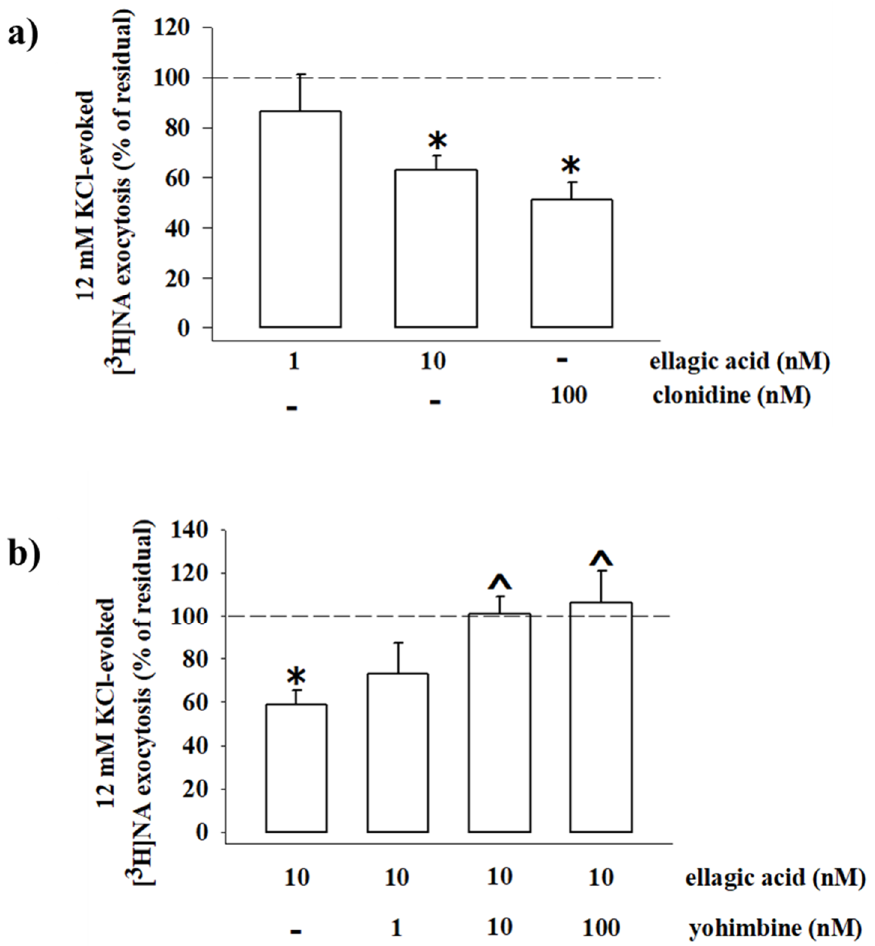
Figure 10. Ellagic acid mimics clonidine in inhibiting the 3 [H]noradrenaline ( 3 [H]NA) exocytosis from mouse hippocampal synaptosomes, and its effect is reversed by yohimbine. ( a ) Effects of ellagic acid (1 and 10 nM) and clonidine (100 nM) on the 12 mM KCl-evoked 3 [H]NA release from mouse hippocampal synaptosomes. ( b ) Effect of ellagic acid (10 nM), alone or concomitantly added with yohimbine (1–100 nM), on the 12 mM KCl-evoked 3 [H]NA release from mouse hippocampal synaptosomes. Results are expressed as percentage of residual of the 12 mM KCl-evoked tritium release. Data represent the means ± SEM of four to five experiments run in triplicate. * p < 0.05 versus 12 mM KCl-induced tritium overflow; ˆ p < 0.05 versus 12 mM KCl/10 nM ellagic acid-induced tritium